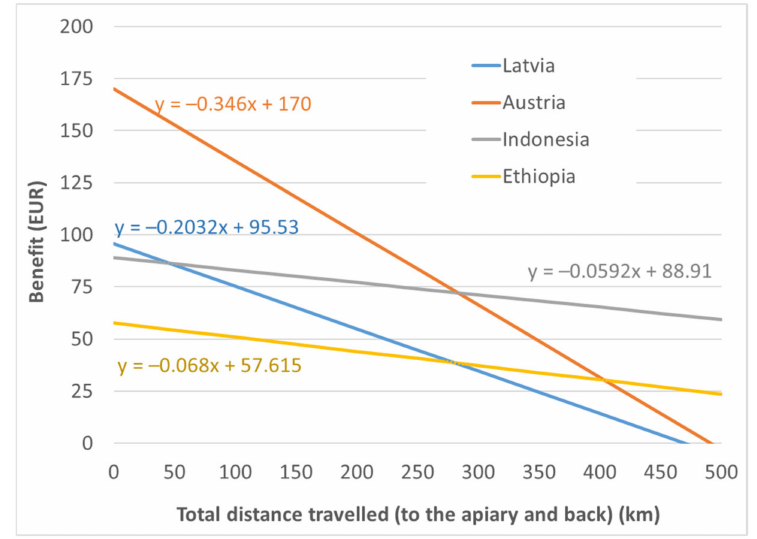
Figure 2. Model outcome showing the relationship between travelled distance and benefit in four different countries.